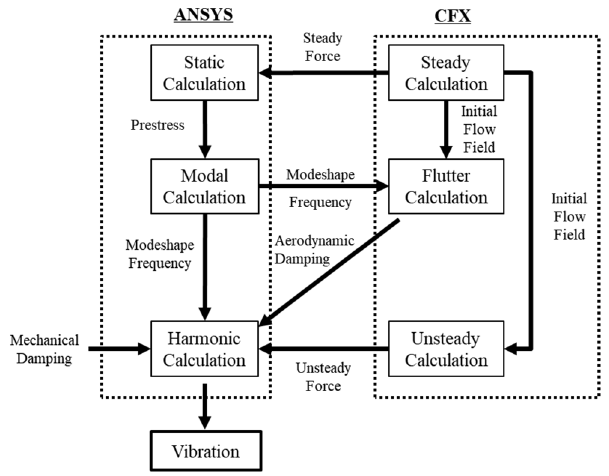
Figure 3. Vibration calculation method.